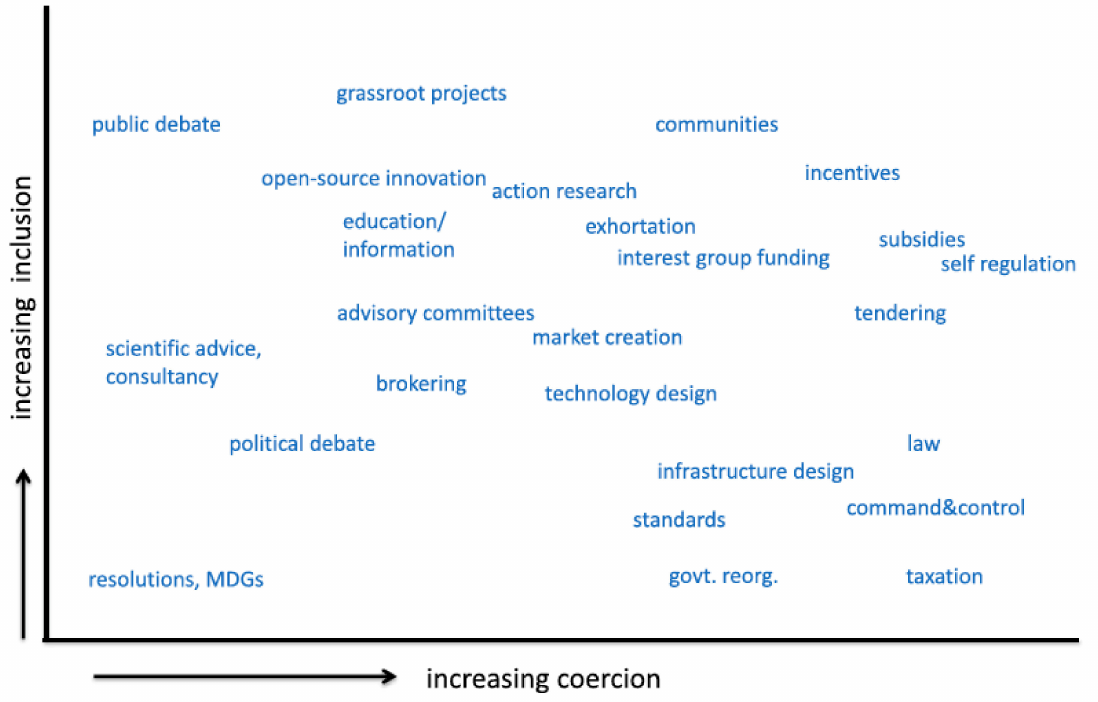
Figure 1. A two-dimensional classification of conventional modes of governance. Source: Valkenburg and Cotella [42] (p.